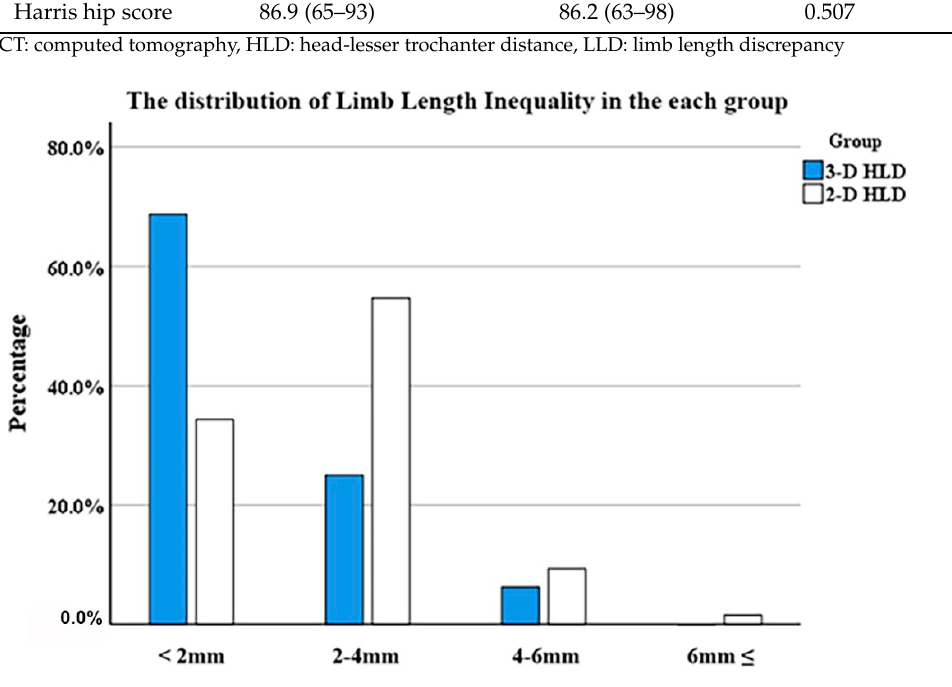
Figure 7. Leg length discrepancy distribution in the 2-D and 3-D HLD